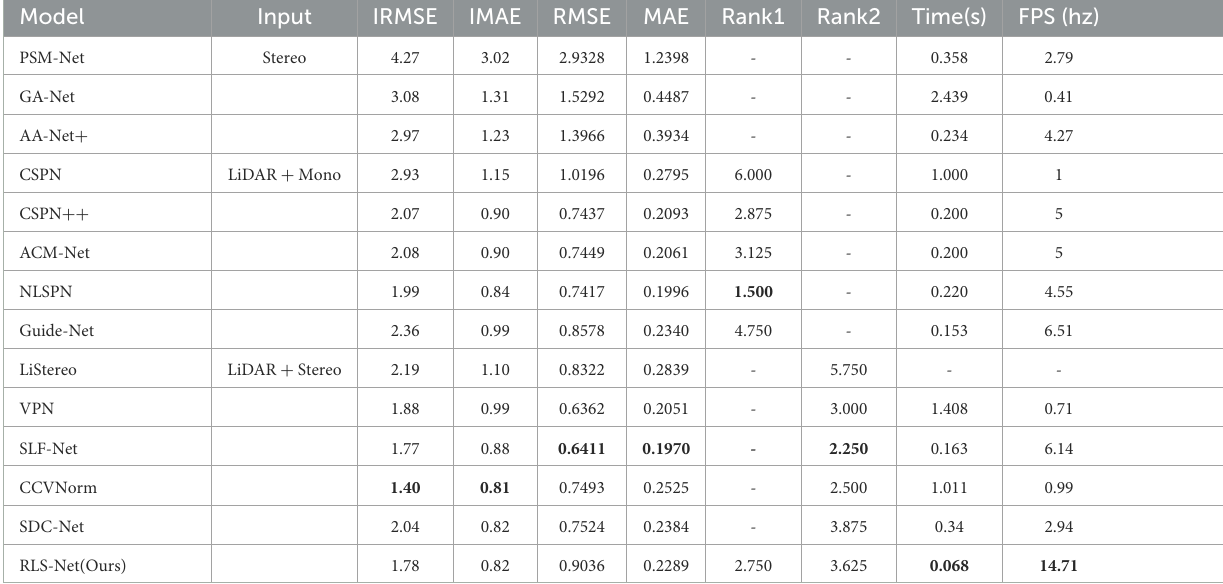
TABLE 2 Comparison of fusion network results on